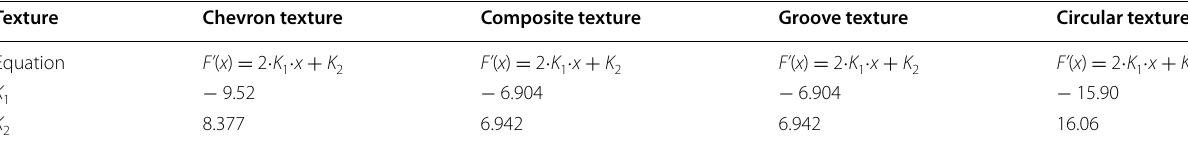
Table 4 Derivatives of four texture equations Texture Chevron texture